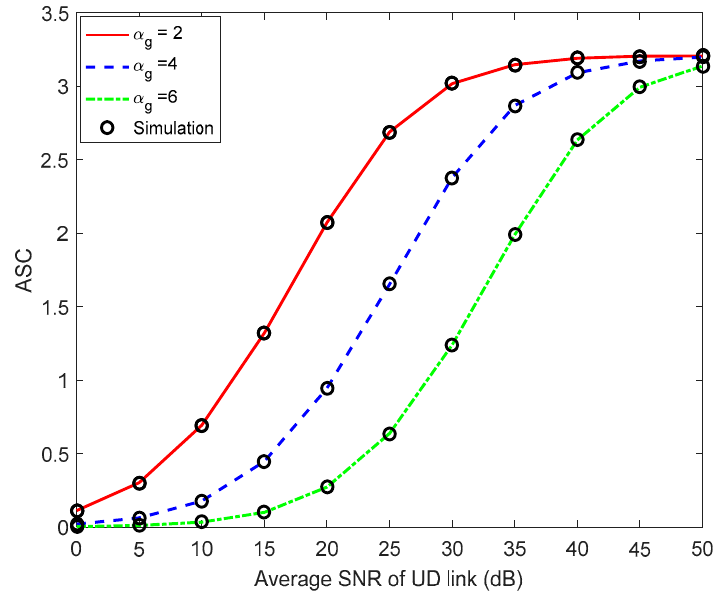
Figure 10. Effect of path loss factor α g on the network ASC when γ BU = 15 dB, γ UE = 5 dB, and ρ e = 4 × 10 − 8